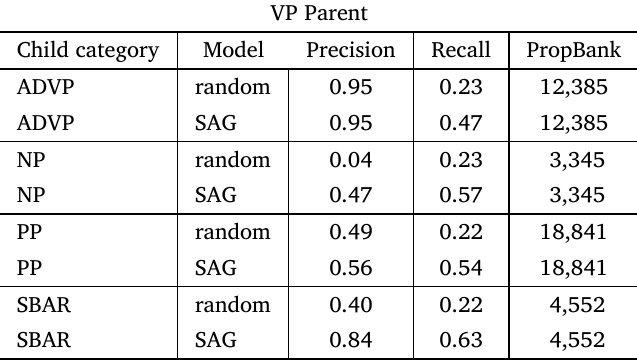
Table 2: Labelings for modifiers of VP nodes, broken down by child